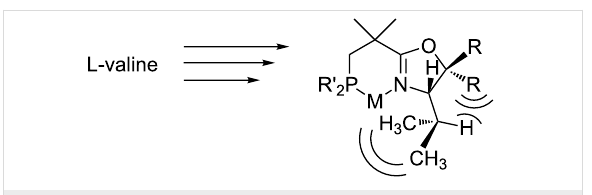
Figure 3: Employing L-valine as a starting material for C5 substituted oxazoline. ties in the hydrogenation of various test substrates were much lower than those induced by the tert- butyloxazoline analog with the exception of the result obtained with the allylic alcohol S2 (Table 1). Surprisingly, the presence of two geminal phenyl substituents at C(5) had a negative impact on the enantioselec- tivity, as shown by the substantially higher ee values induced by the analogous catalyst Ir-1a [28] lacking substituents at